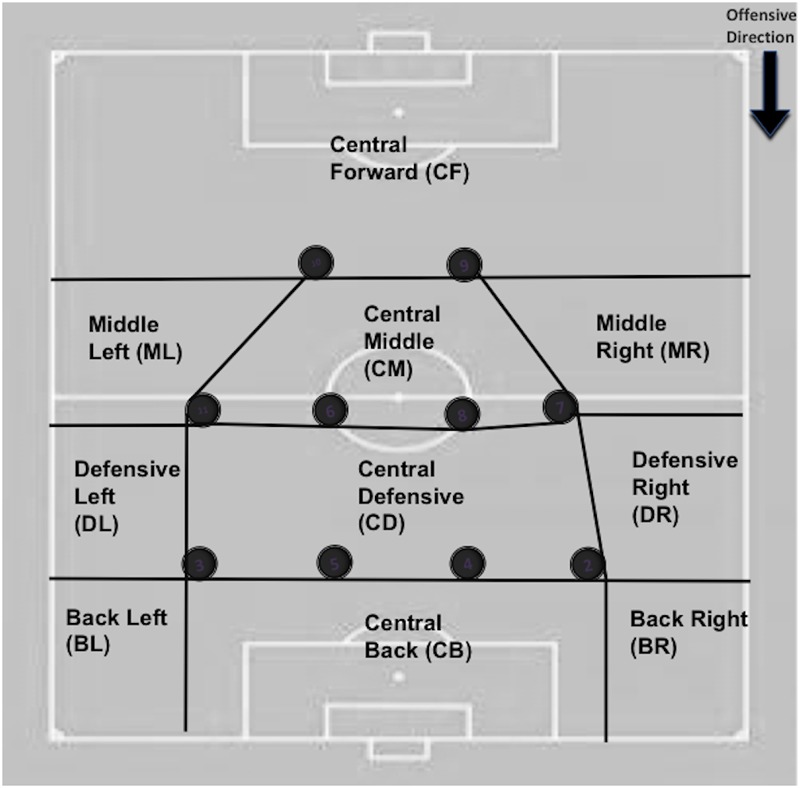
Space of defensive occupation that define the level of invasion over the opponent (Adapted from previous studies, Castellano, 2000; Gréhaigne, 2001; Seabra and Dantas, 2006; Aranda et al., 2009). These zones are dynamic and change every second depending on the positioning on the opposing players.